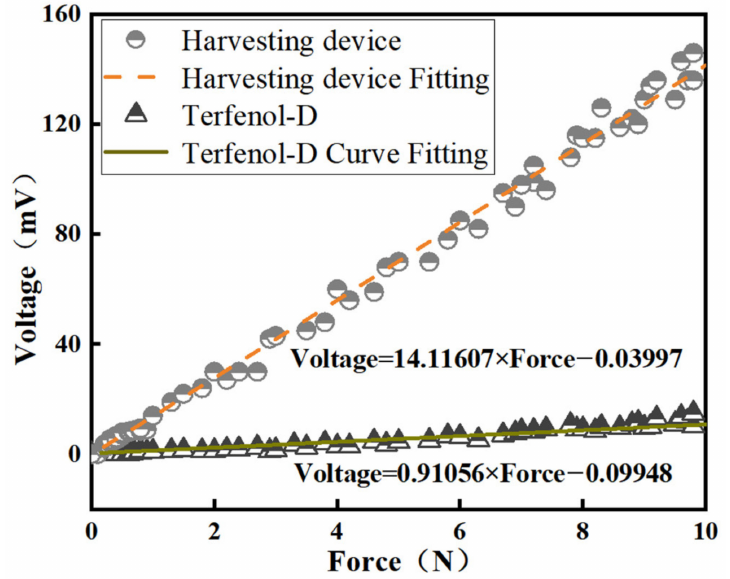
Figure 14. Force amplification ratio test results of the double-stage rhombus energy harvesting device